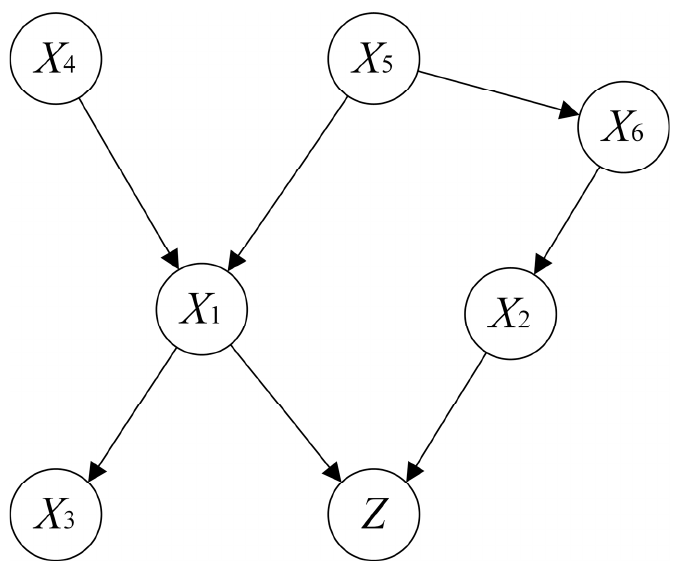
Figure 3. Description diagram of node relationship.